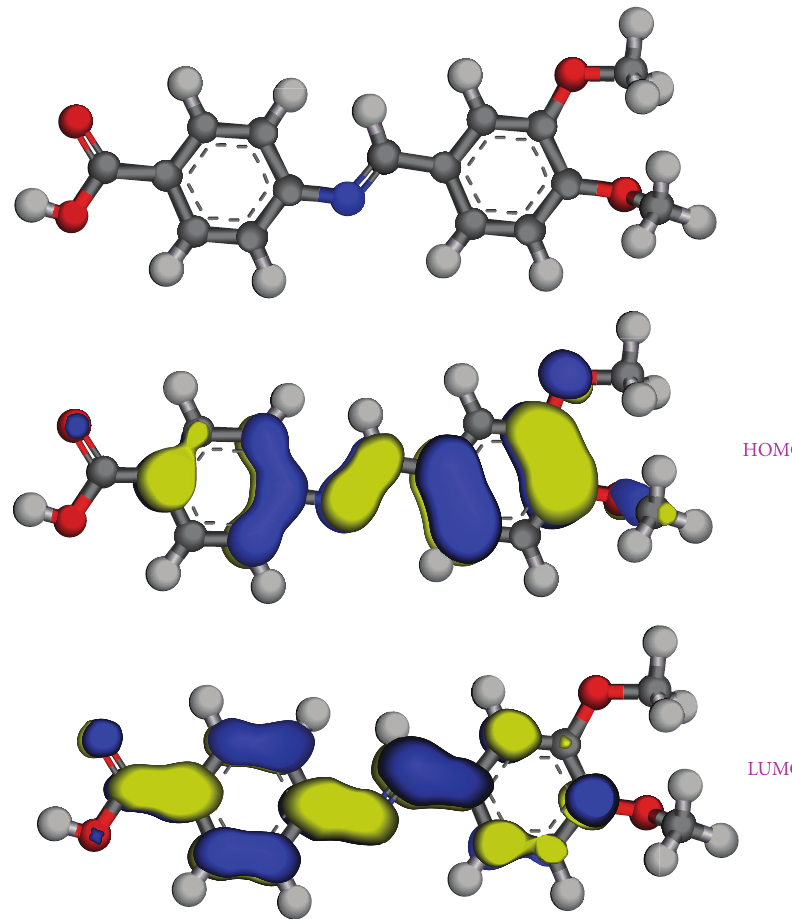
Figure 2: Optimized geometric structure, HOMO, and LUMO of SBDA.